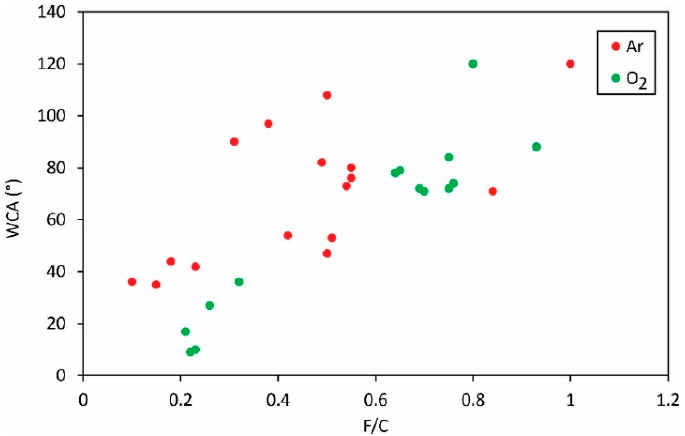
Figure 6. The static water contact angle versus the F/C ratio in the surface film as probed by XPS. Different authors reported various initial water contact angles, i.e., the static WCA for a sample before any plasma treatment. The WCAs after the plasma treatment as shown in Figures 5 and 6 may, therefore, not be the most representative results. An important result may be the change in the water contact angle, i.e., the difference between the initial and the final water contact angle. The difference of the O/C versus the F/C ratio, respectively, is plotted in Figures 7 and 8.